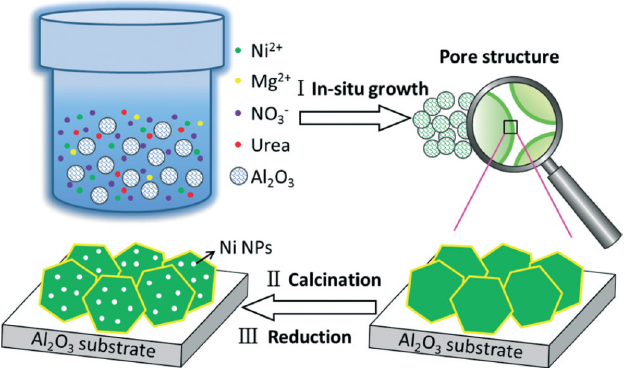
Figure 1. Schematic synthesis route of the catalysts from HTLc precursors grown in situ on an alumina substrate. Reproduced from [25] with permission of The Royal Society of Chemistry. Copyright 2014.